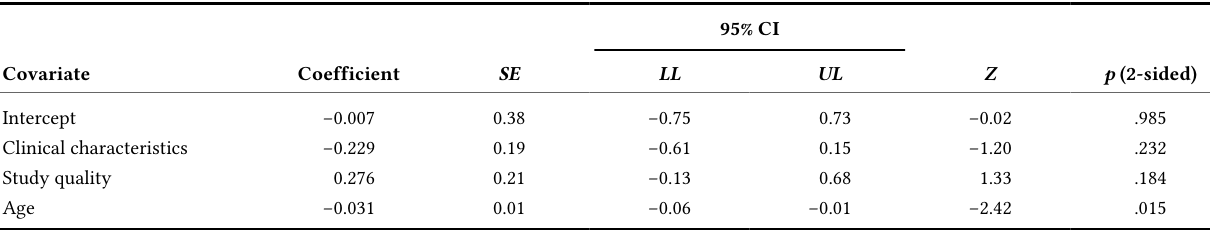
Moderating Testing (Random Effects, REML